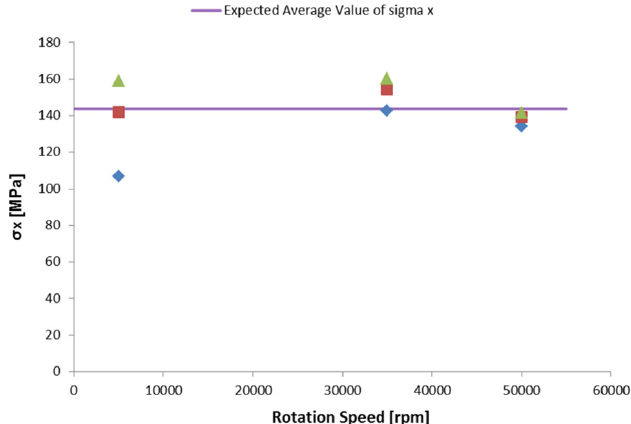
Figure 8: Plot of the measured stress at the different rotations speed of the